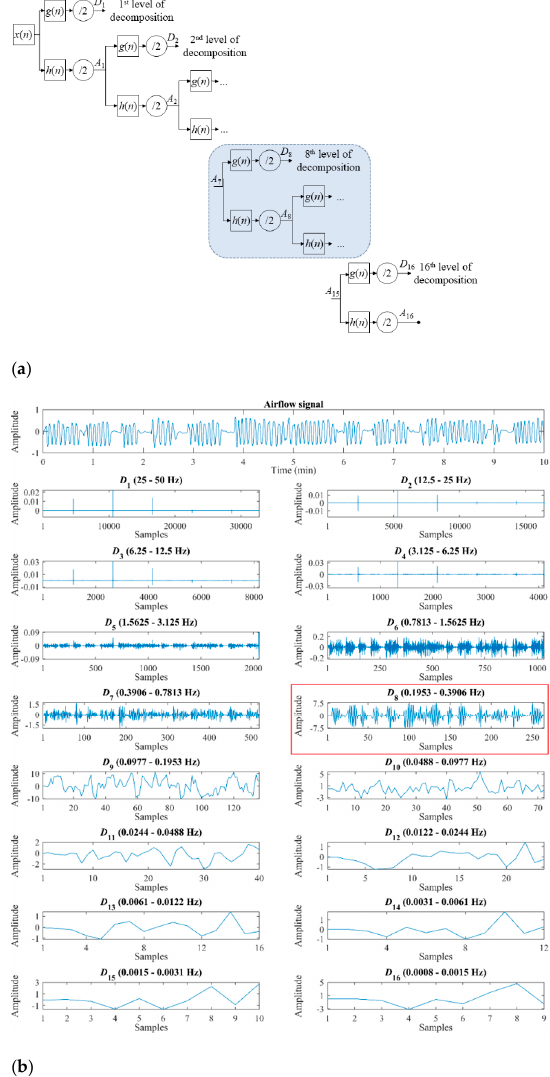
Figure 2. ( a ) Wavelet decomposition where x ( n ) is the time series, g ( n ) are half-band high-pass filters, h ( n ) are half-band low-pass filters, /2 are subsampling processes, and D j and A j are detail and approximation signals of the decomposition level j , respectively. ( b ) Detailed signals at each decomposition level of airflow signal.